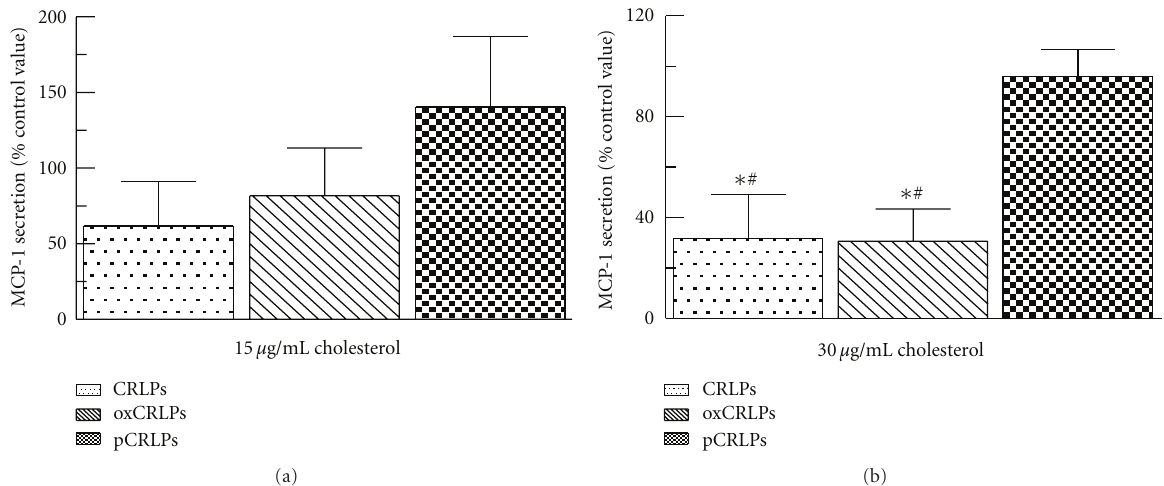
Figure 3: MCP-1 production by human primary blood monocytes after incubation with native, oxidised, or probucol-treated CRLPs. Monocytes were incubated with CRLPs, oxCRLPs or pCRLPs (a) 15 μ g/mL cholesterol; (b) 30 μ g/mL cholesterol) for 24h at 37 ◦ C. After this time cells were pelleted and the supernatants were collected for analysis by ELISA. n = 3 monocyte isolations. ∗ P < 0 . 05 compared to control, # P < 0 . 05 compared to pCRLPs-treated monocytes. One-way ANOVA with Bonferroni’s